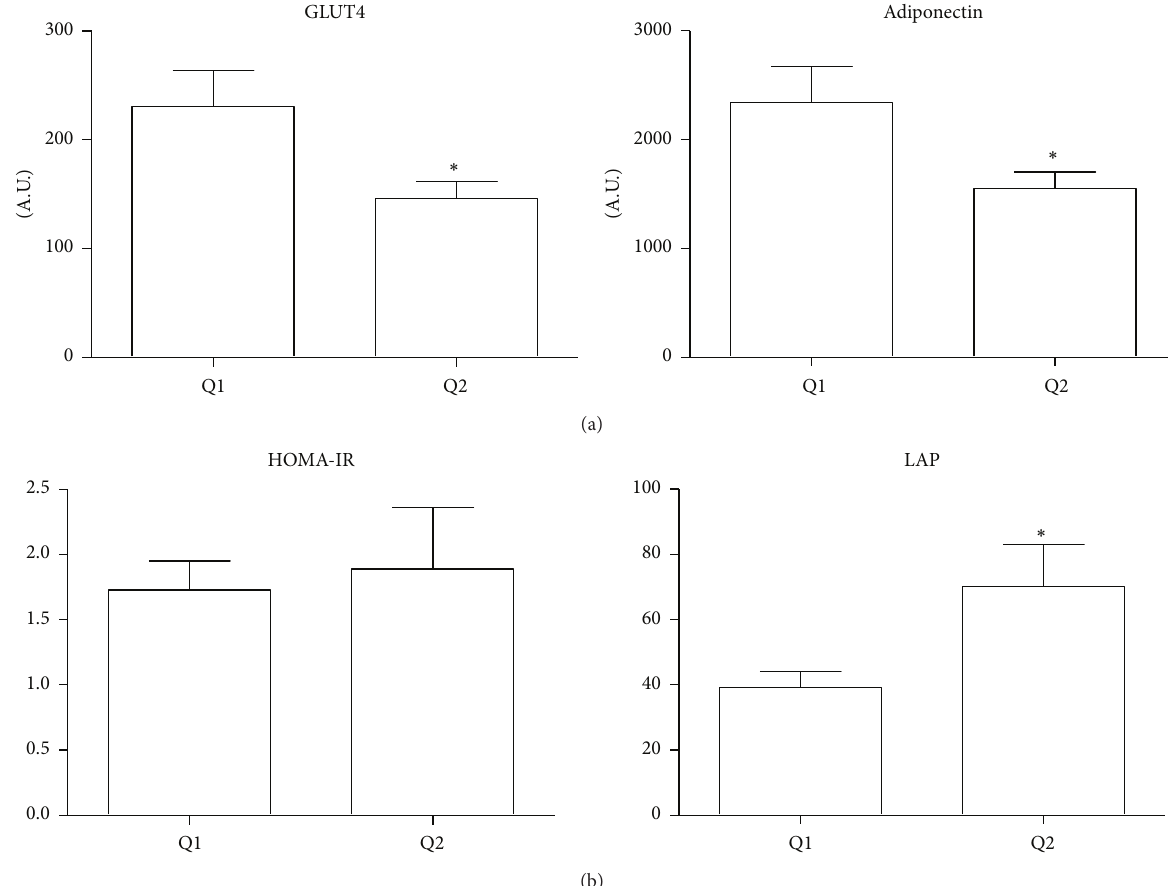
Figure 2: Relationship between RAGE expression in EAT and indices of insulin sensitivity. CAD patients were stratified into two groups (Q1 and Q2) on the basis of the median RAGE expression in EAT. (a) Gene expression of GLUT4 and adiponectin in EAT was compared in the two groups. (b) HOMA-IR and LAP were compared in the two groups. Data are expressed as mean ± SD; ∗ 𝑝 < 0.05